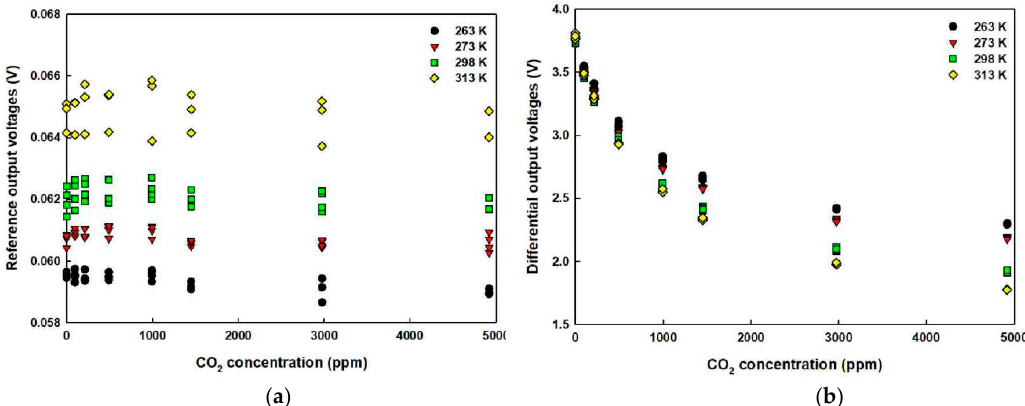
Figure 1. Output voltages of IR detectors as a function of CO 2 concentrations and ambient temperatures: ( a ) reference output voltages; ( b ) amplified differential output voltages between CO 2 and reference detector.